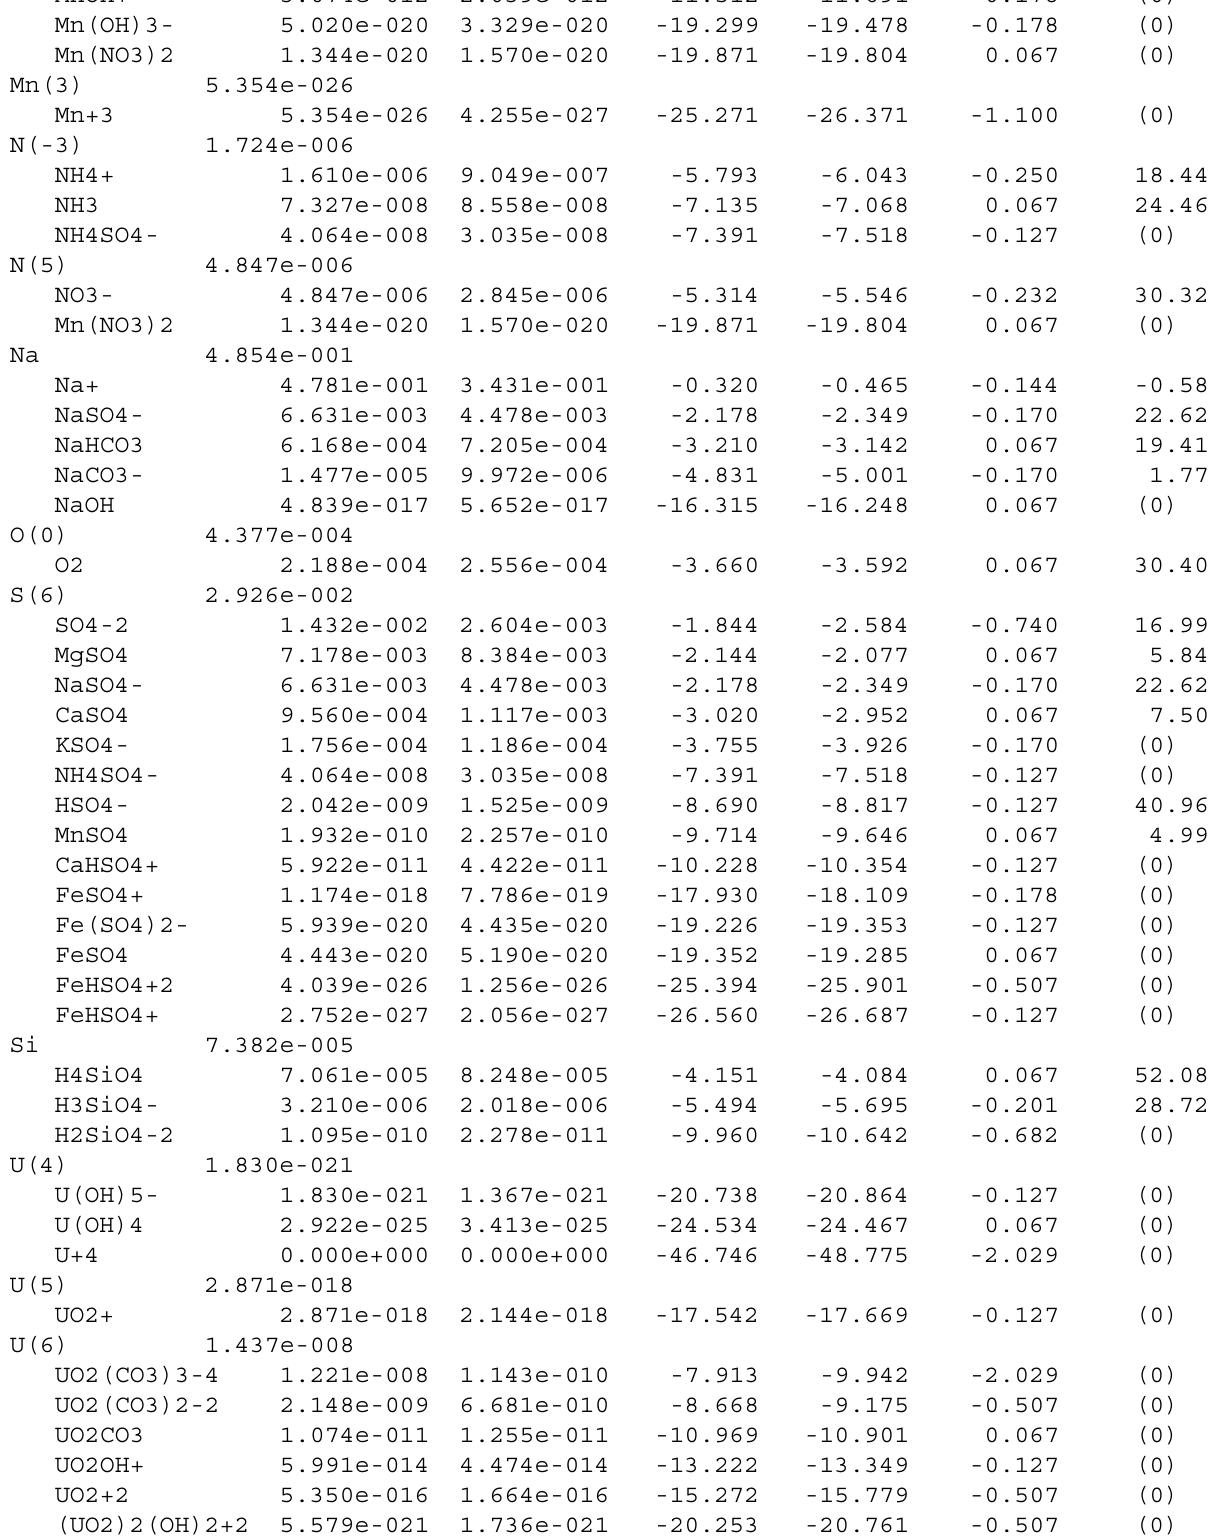
Table 11. Output for example